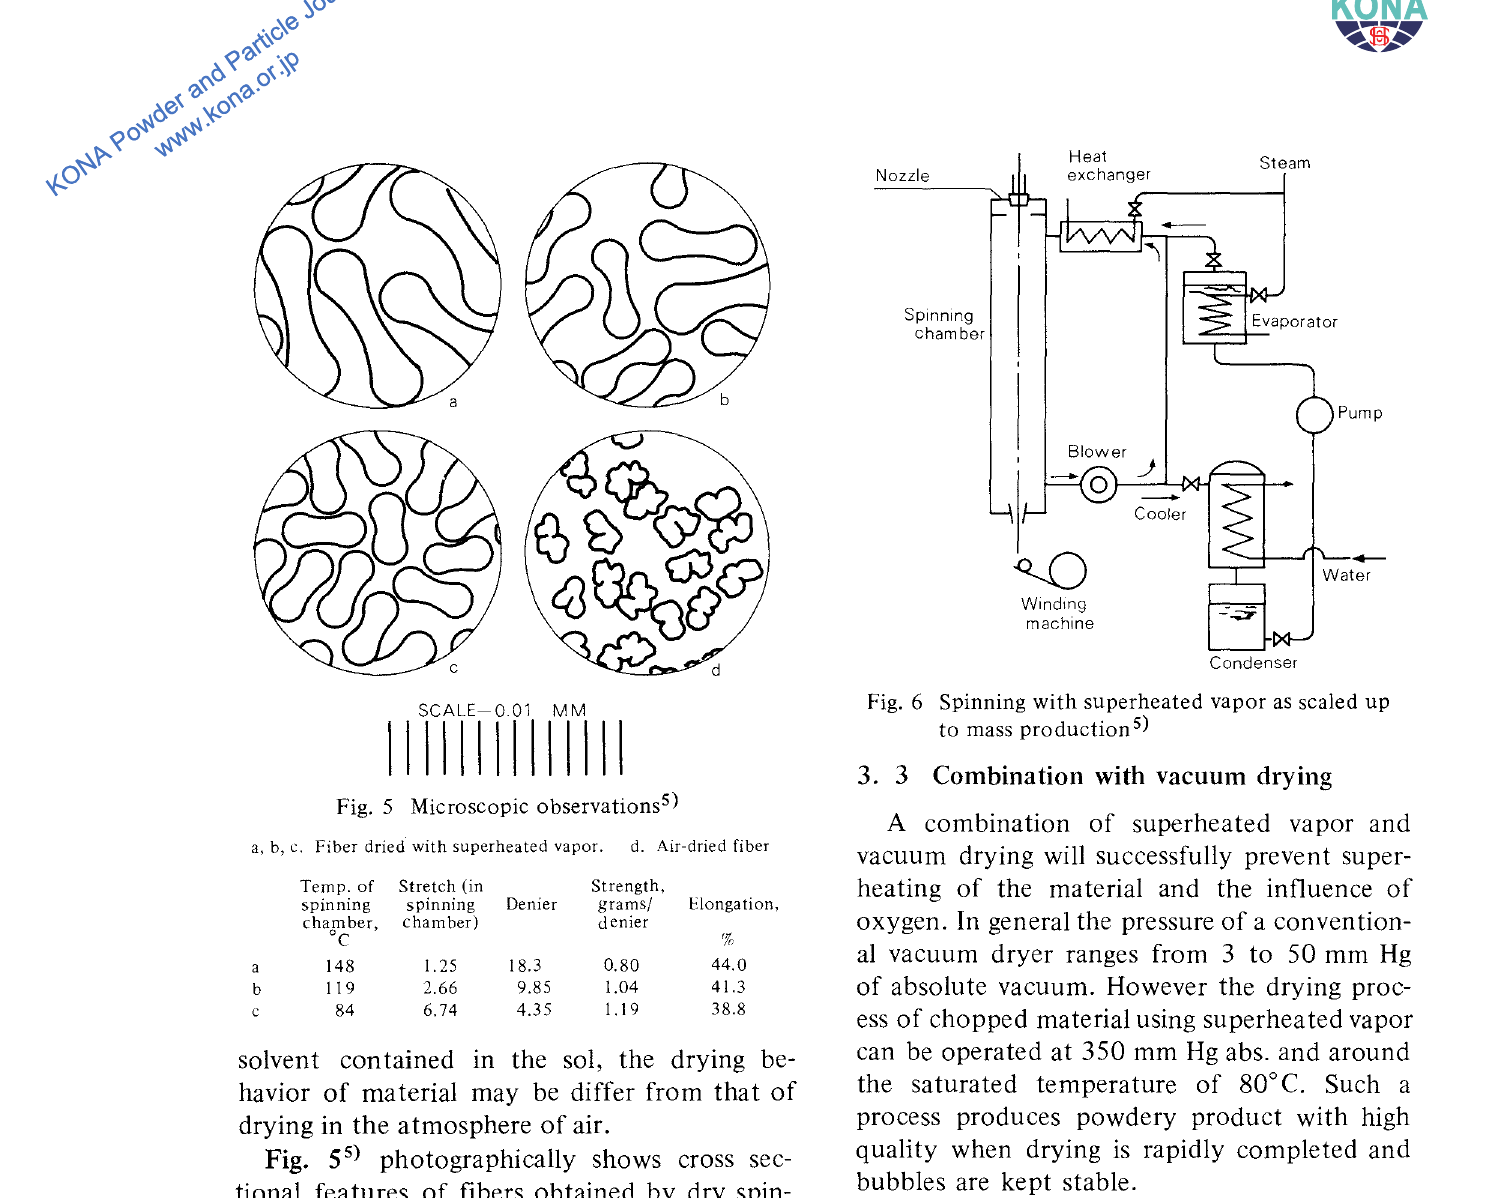
Fig. 6 Spinning with superheated vapor as scaled up to mass production